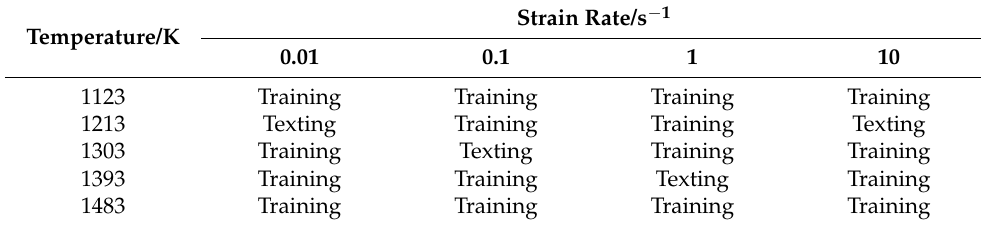
Table 3. Specimen division of SAE 5137H steel.